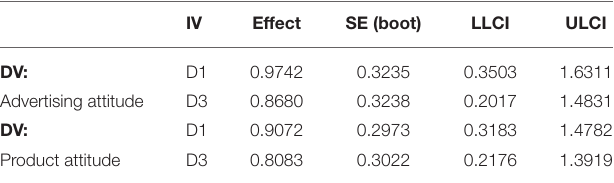
TABLE 2 | The mediation effect of mental imagery in Experiment